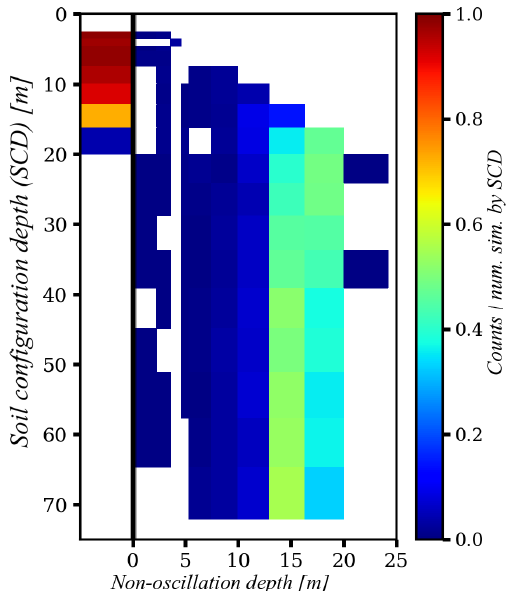
Figure 8. The 2-D histogram of SCD and h T -non-oscillation depth. Counts are normalized by the number of simulations per SCD. The thick black line separates the frequency of reaching and not reach- ing the h T -non-oscillation conditions; bins to the left of this line are for simulations that never reached the h T -non-oscillation condition.